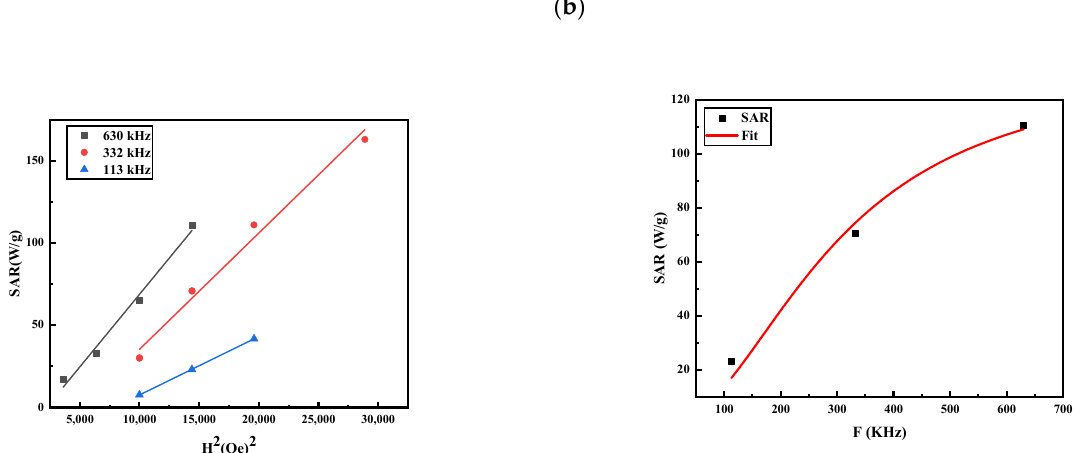
Figure 8. LRT model fitting the experimental SARs ( a ) with the square of field amplitude and ( b ) with the frequency at field H 0 = 120 Oe using Equation (12).